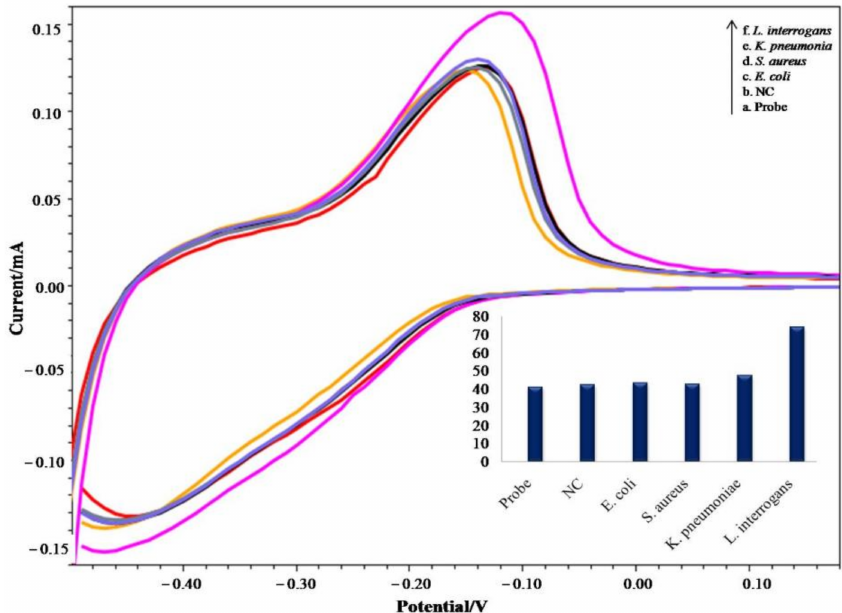
Figure 6. Evaluation of the DNA sensor specificity with L. interrogans and other bacterial species ( Escherichia coli, Staphylococcus aureus , and Klebsiella pneumoniae ) using cyclic voltametric studies (NC= Negative Control). The insert shows the relative Ip values (with respect to the probe) of the DNA sensor with the hybridizing GDNA of L. interrogans and other